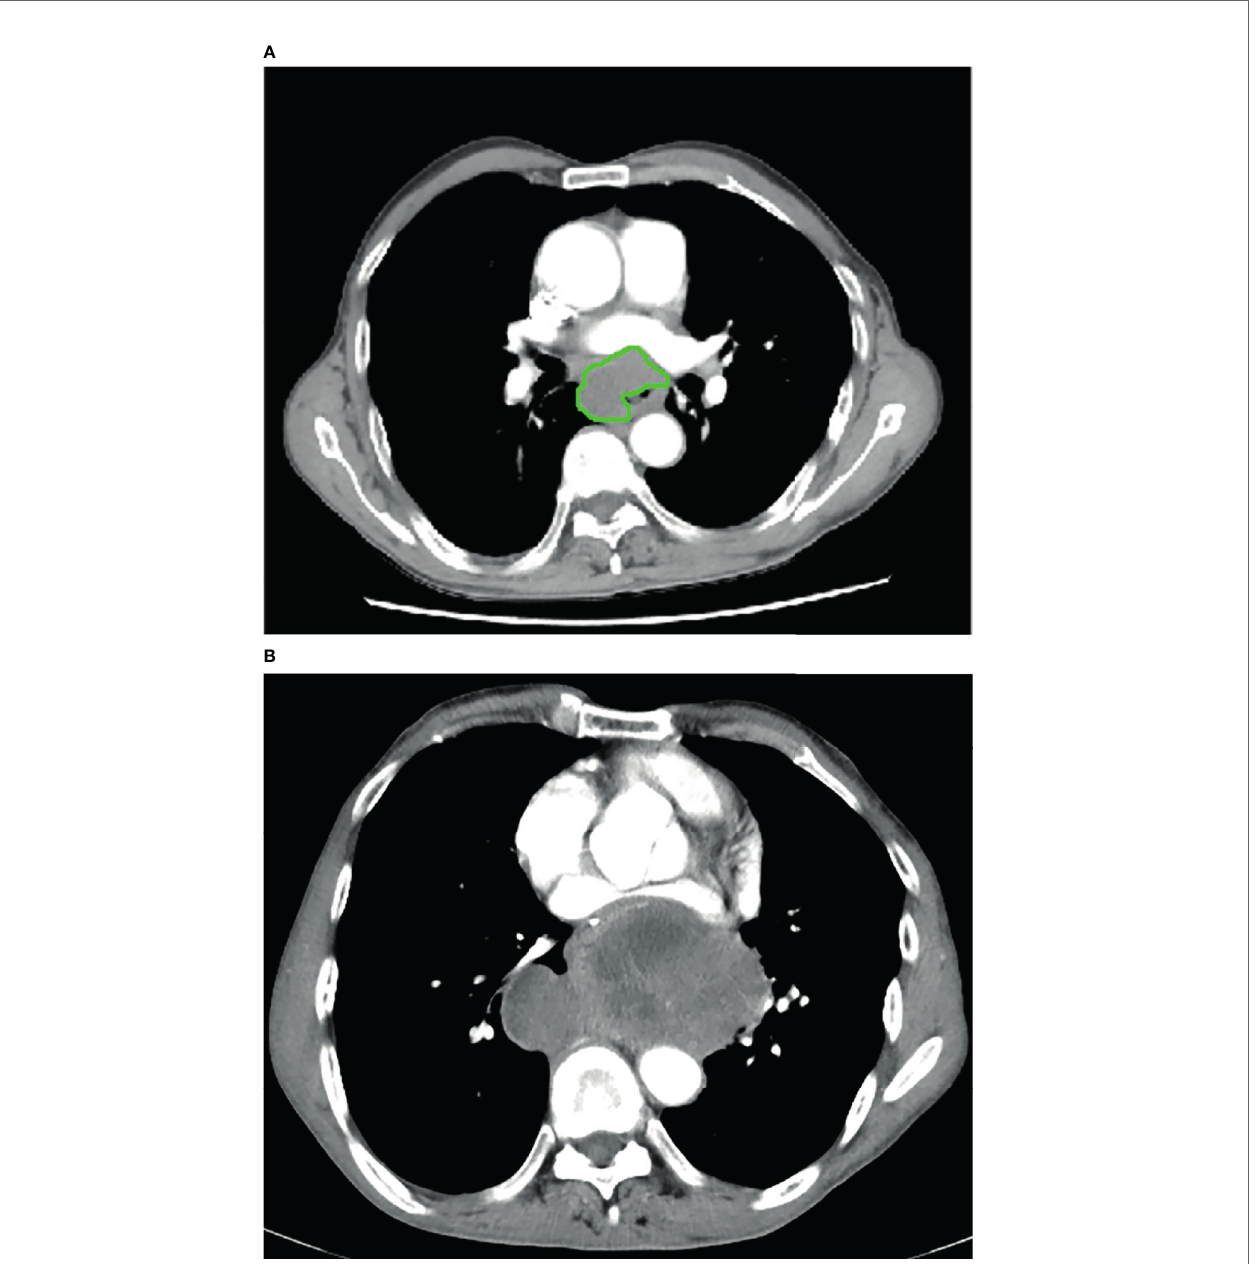
FIGURE 1 | In a 61-year-old male with esophageal squamous cell carcinoma at cT 2 N 0 M 0 , the preoperative thoracic contrast-enhanced CT scans depict the gross tumor volume obtained by manual delineation along the margin of the abnormal esophageal wall (A) slice-by-slice, and the gross tumor volume is 58.66 cm 3 . Regional and local recurrence has been found 12 months after radical esophagectomy during the follow-up period (B)